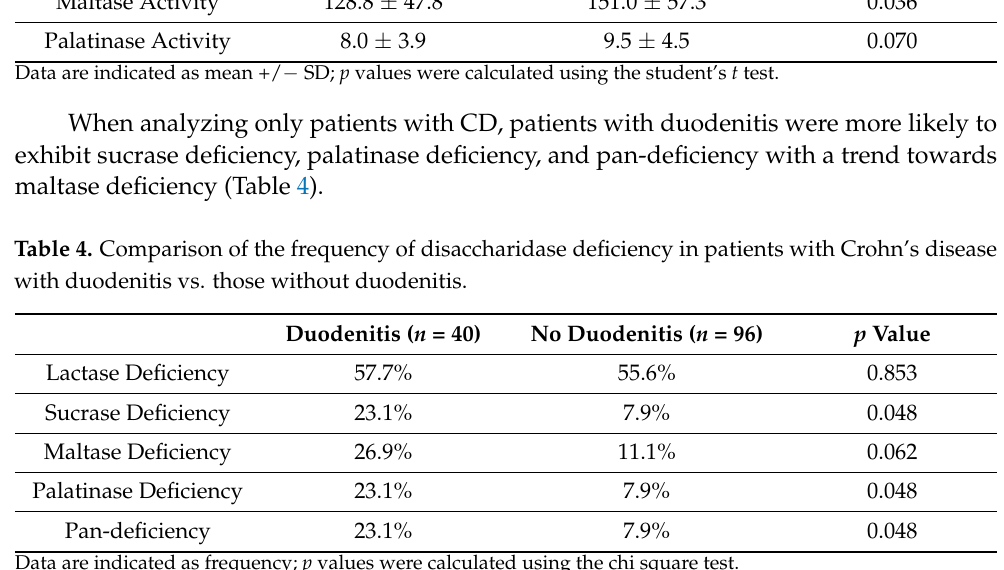
Table 2. Comparison of the frequency of disaccharidase deficiency in patients with inflammatory bowel disease with duodenitis vs. those without duodenitis. Duodenitis ( n = 38) No Duodenitis ( n = 98) p Value Lactase Deficiency 57.9% 55.1% 0.769 Sucrase Deficiency 21.1% 11.2% 0.138 Maltase Deficiency 28.9% 16.3% Palatinase Deficiency 21.1% 11.2% 0.138 Pan-deficiency 21.1% 9.2% 0.060 Data are indicated as frequency; p values were calculated using the chi square test. Table 3. Comparison of mean disaccharidase activity levels (umol/min/gram protein) in patients with inflammatory bowel disease with duodenitis vs. those without duodenitis. Duodenitis ( n = 38) No Duodenitis ( n = 98) p Value Lactase Activity 14.1 ± 12.3